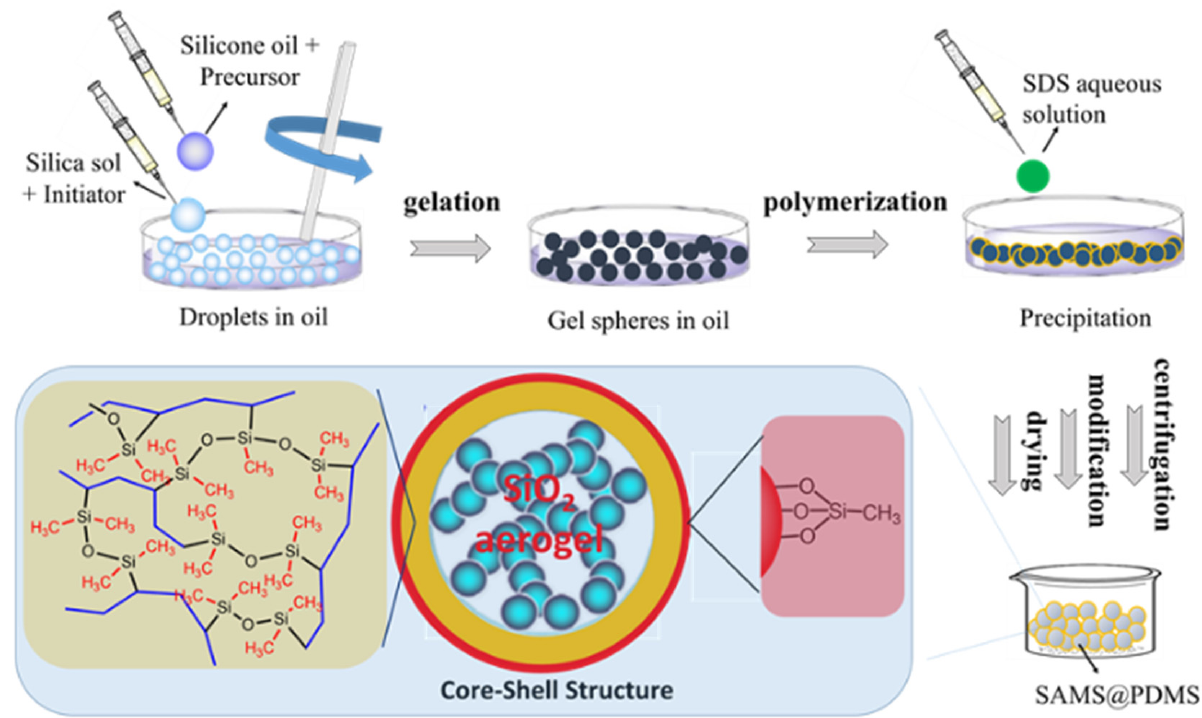
Figure 1. Schematic representation of the fabrication process and the core–shell structure of the PDMS-coated SiO 2 aerogel microspheres (SAMS@PDMS).